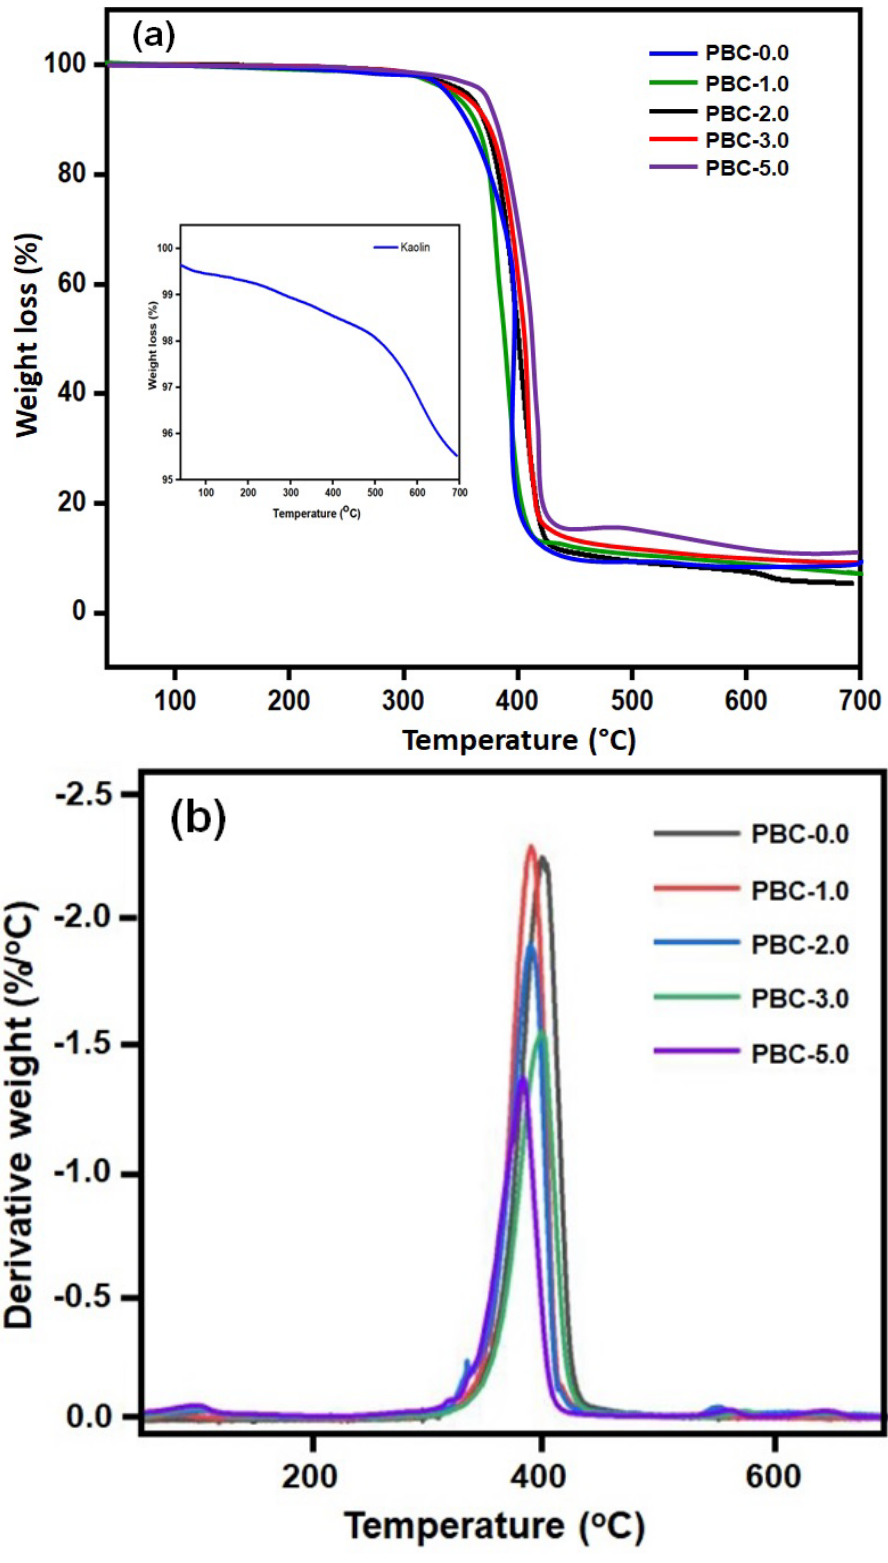
Figure 3. ( a ) TGA curves of PBAT and PBAT/kaolin clay composite samples. ( b ) DTG curves of PBAT and PBAT/kaolin clay composites.